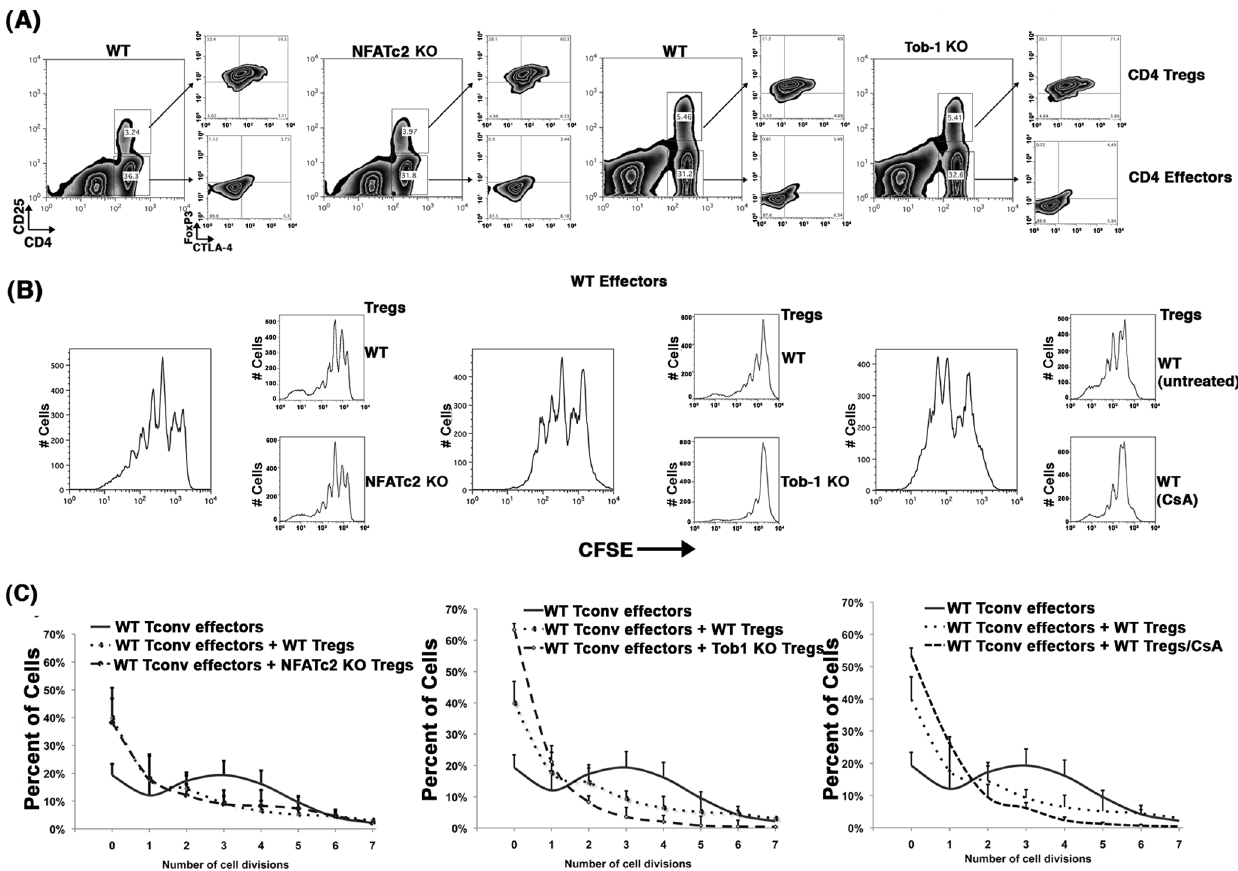
Figure 3. T cell expansion in Nfatc2 and Tob1 KO mice is not due to Treg dysfunction. CD4 T cells were isolated from single cell suspensions of spleens and lymph nodes from age-matched WT, Nfatc2 KO, and Tob1 KO mice by negative immunomagnetic selection. CD4 + CD25 2 (Tconv) cells and CD4 + CD25 + (Tregs) were enriched by sorting. Tconv cells were labeled with CFSE and Treg cells were labeled with PKH26. Tconvs (100,000/well) were then mixed 1:1 with syngeneic AgPCs and stimulated with anti-CD3 in the presence of absence of 50,000 Treg cells as indicated. Proliferation was measured by CFSE dilution in CD4 T cells using flow cytometry after of 96 hr of culture. (A) Expression of CD4, CD25, and CTLA-4 was assessed by conventional cell surface staining; expression of Foxp3 was examined by intracellular staining Panels are representative two-dimensional contour plots showing CD4 and CD25 staining from WT, Nfatc2 KO, and Tob1 KO mice gated on CD3 T cells. Boxed areas represent CD4 + CD25 + (Treg) cells and CD4 + CD25 2 (Tconv) cells. Small panels to the right represent two-dimensional contour plots showing CTLA-4 and Foxp3 staining, respectively for Tregs on top and Tconvs below. (B) Representative one-dimensional histograms of CFSE dilution from stimulated WT cells. Small panels to the right represent one-dimensional histograms of CFSE dilution for the same WT cells, respectively with the addition of WT Tregs, Nfatc2 KO Tregs, Tob1 KO Tregs, or WT Tregs treated with CsA as indicated. (C) Means 6 S.D. of the percent of cells that underwent 0–7 divisions over 96 hr for each genotype with and without Tregs. The data summarize 8 experiments using WT Tregs, 4 experiments using Nfatc2 KO Tregs, 2 experiments using Tob1 KO Tregs, and 2 experiments using WT Tregs treated with CsA, each with pooled cells from 2 or 3 mice. The number of WT Tconv cells that did not undergo cell division was significantly greater (p , 0.01), and the number of cells undergoing 2 or more divisions was significantly reduced (p , 0.0001) when Tob1 KO Tregs were present in the culture than when WT Tregs or Nfatc2 KO Tregs were present in the culture.